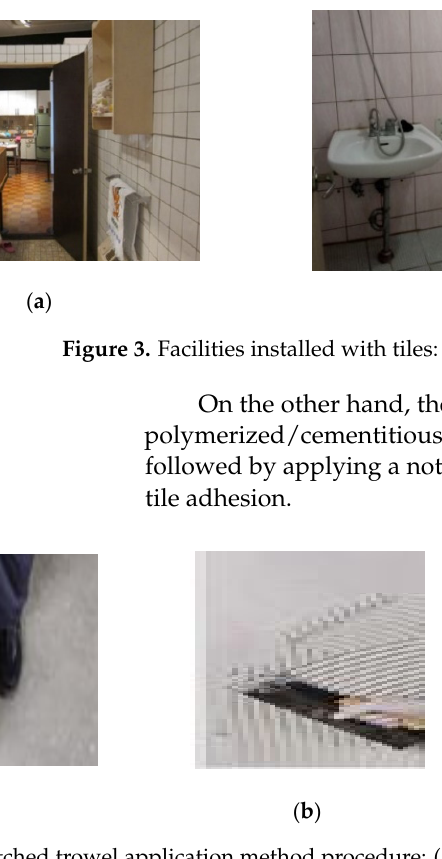
Figure 4. Notched trowel application method procedure: ( a ) adhesive preparation; ( b ) application on substrate surface and creation of 5–7 mm deep channels; ( c ) tile installation; ( d ) securing adhesion with tile and adhesive.